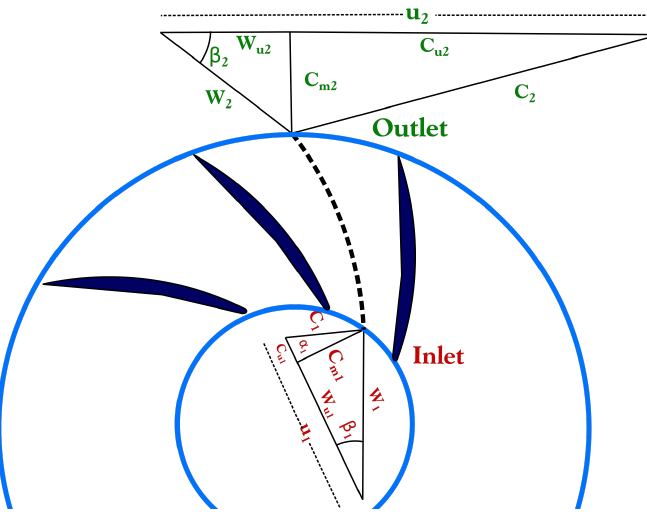
Figure 9. The pump reference